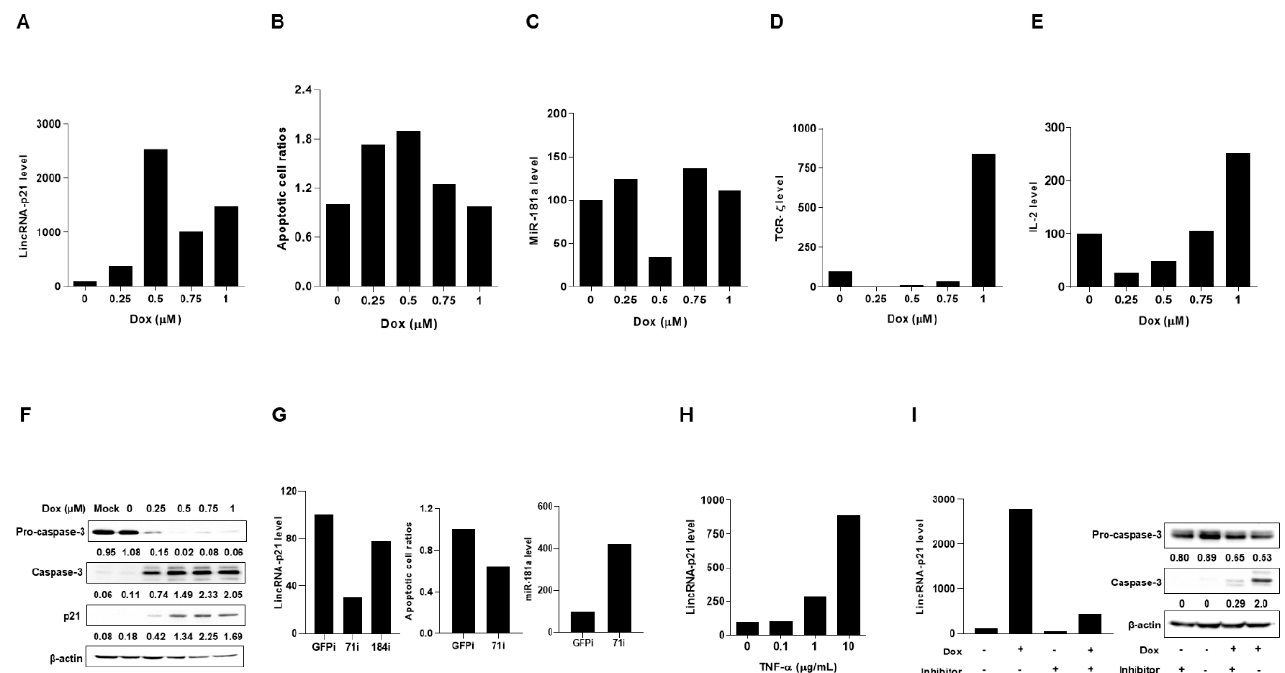
Figure 4. Up-regulated lincRNA-p21 expression in apoptotic T-lymphocyte cell line. ( A – F ) Dose-dependent up-regulated lincRNA-p21 levels, apoptotic cell ratios and caspase 3/p21 levels with reciprocal down-regulated miR-181a levels and reduced expression of TCR- ζ chain and IL-2 in Jurkat cells culture under the Dox treatment. ( G ) Two CRISPRi-lincRNA-p21 transfectants and decreased Dox-induced apoptotic cell ratios with increased miR-181a levels shown in 71i with higher silenced efficacy. ( H ) Dose-dependent increases in lincRNA-p21 levels in cell culture in the presence of TNF- α ( I ) Down- regulated expression of lincRNA-p21 in the presence of caspase 3 inhibitor in the cell culture under the Dox treatment. All of the results in Figure 4 were representative of at least two independent experiments with similar findings.